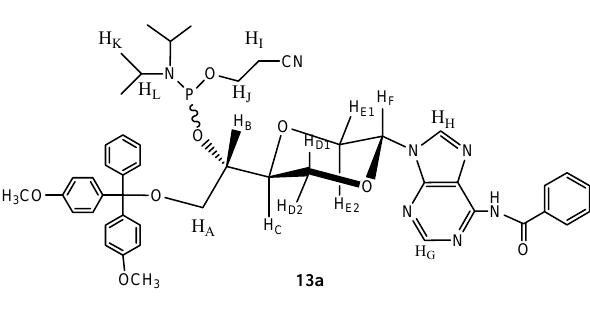
Figure 7. Structure of compound 13a